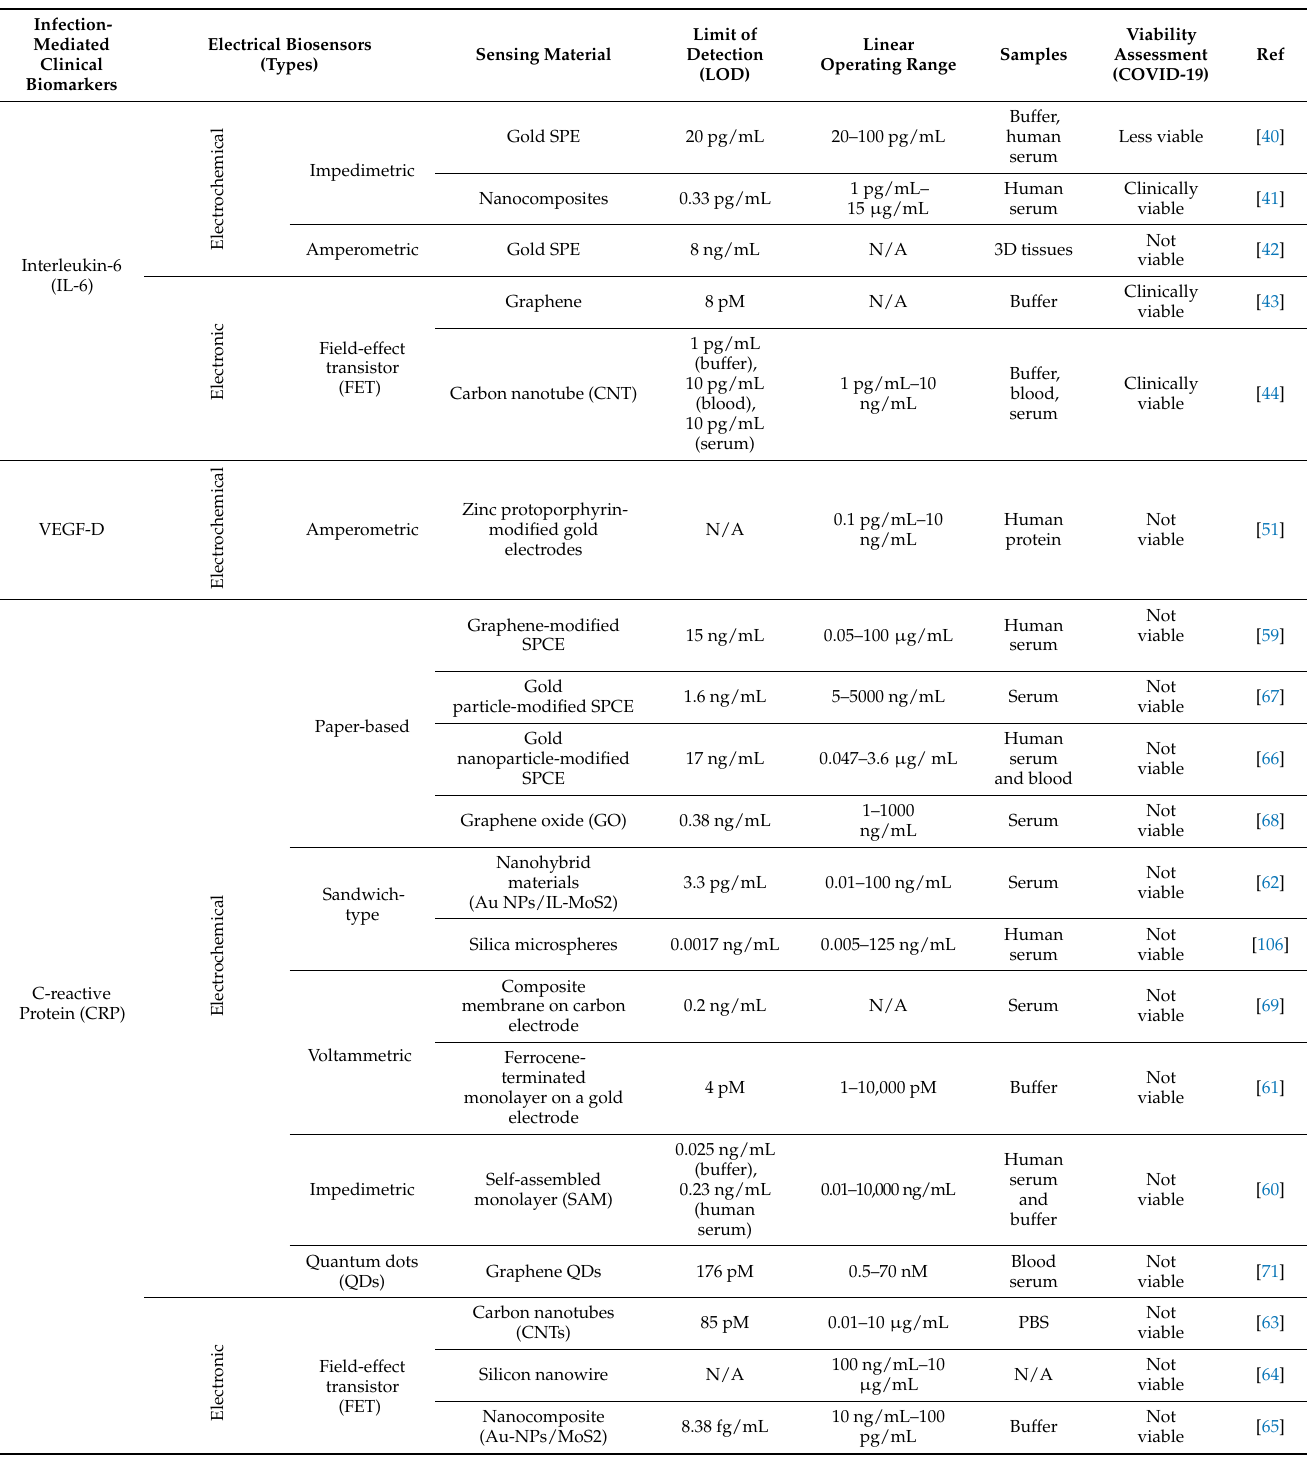
Table 2. Performance aspects and viability assessment of recently reported electrical biosensors associated with infection- mediated clinical